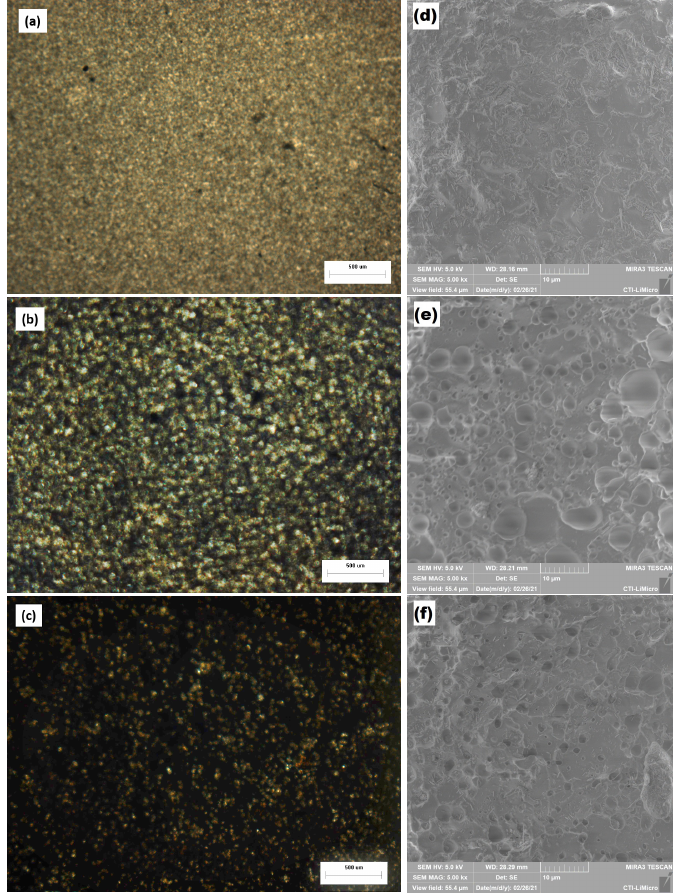
Figure 5. Images obtained by optical microscopy ( a – c ), and SEM ( d – f ) of the samples prepared. ( a , d ) PDMS; ( b , e ) PDMS: 2% weight GO; ( c , f ) PDMS: 4% weight